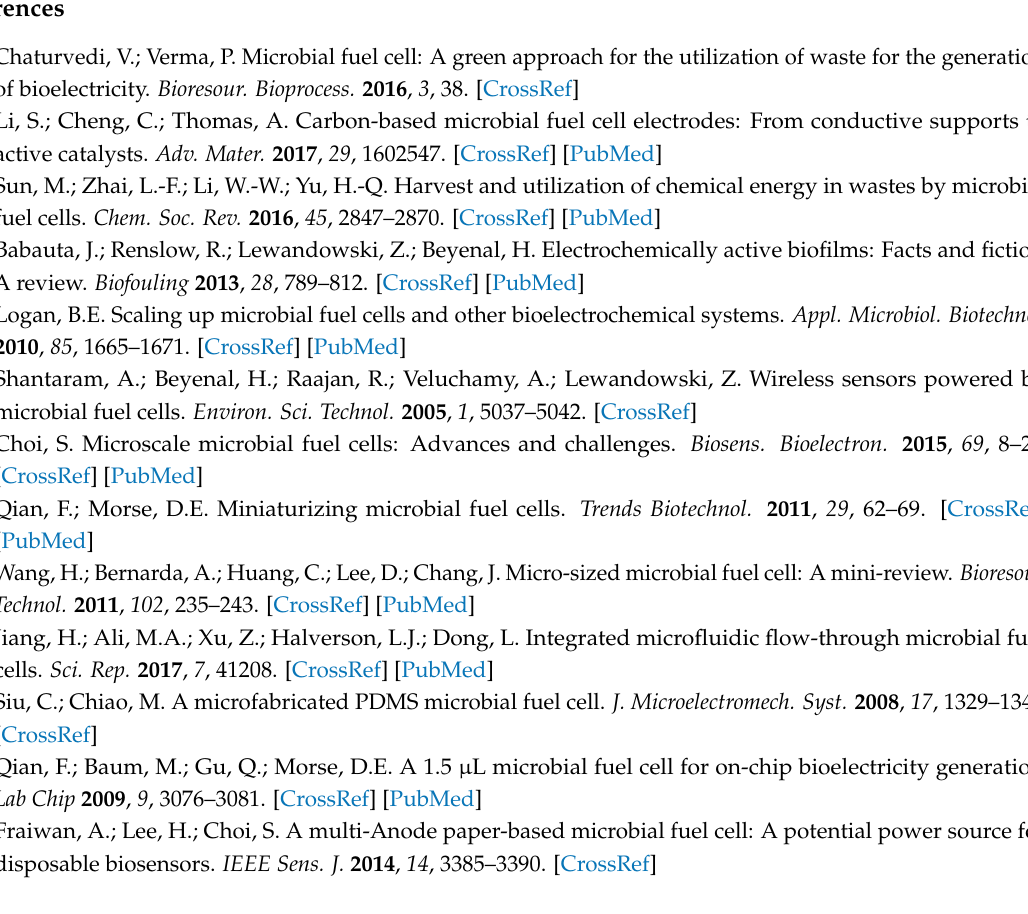
Figure S1: Fabrication processes, Figure S2: SEM images of the compartments, Figure S3: SEM images of bacteria, Figure S4: Device